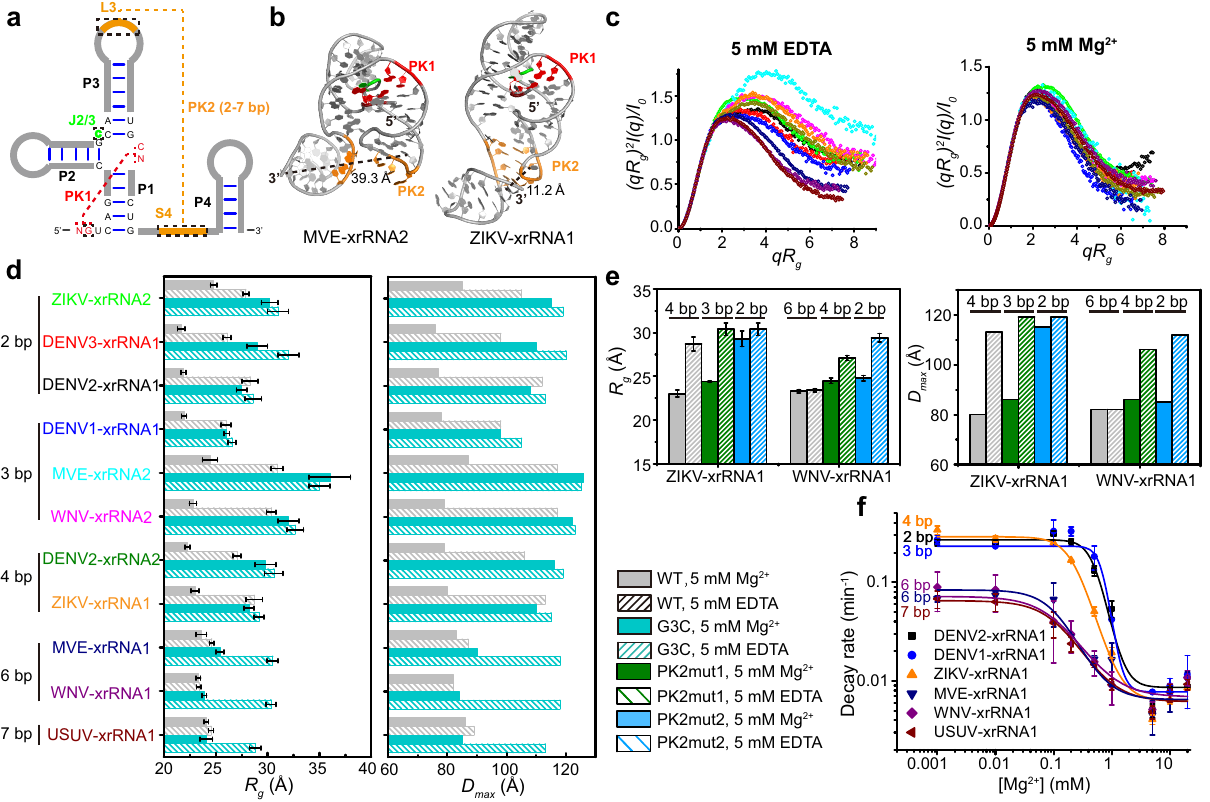
Fig. 1 Mg 2 + -dependence of fl aviviral xrRNAs ’ folding and robustness of Xrn1 resistance is modulated by PK2 length variations. a Schematic representation of the secondary structure for fl aviviral subclass 1a xrRNAs. The red and orange lines indicate the PK1 and PK2 pseudoknot interactions, respectively. The conserved nucleotide C between P2 and P3 (J2/3) is colored in green. N represents any nucleotides. Sites for mutations to disrupt the key tertiary interaction motifs are indicated with the dashed boxes. b Crystal structures of MVE-xrRNA2 (PDB ID: 4PQV) and ZIKV-xrRNA1 (PDB ID: 5TPY). The color codes are the same as that in a . The distances between residues corresponding to the labeling sites in L3 and the 3 ′ -end of the dye-labeled xrRNAs are measured. c The dimensionless Kratky plots for a set of 11 xrRNAs in 5 mM Mg 2 + or EDTA. d – e R g and D max for the WT and G3C mutants of a set of 11 xrRNAs ( d ) and PK2 mutants of ZIKV- and WNV- xrRNA1 ( e ). The color codes for the respective xrRNAs in c – d are the same. Each column in d – e represents an independent experiment ( n = 1) and the error bars are propagated uncertainties calculated by GNOM. f Relative Xrn1 decay rates for xrRNA1s versus Mg 2 + concentrations. The decay rates were calculated by fi tting the fl uorescence traces (see supplementary Fig. 4e – j) with a single exponential curve. Data are presented as mean values ± SEM from three independent experiments. Source data for c and f are provided as a Source Data fi